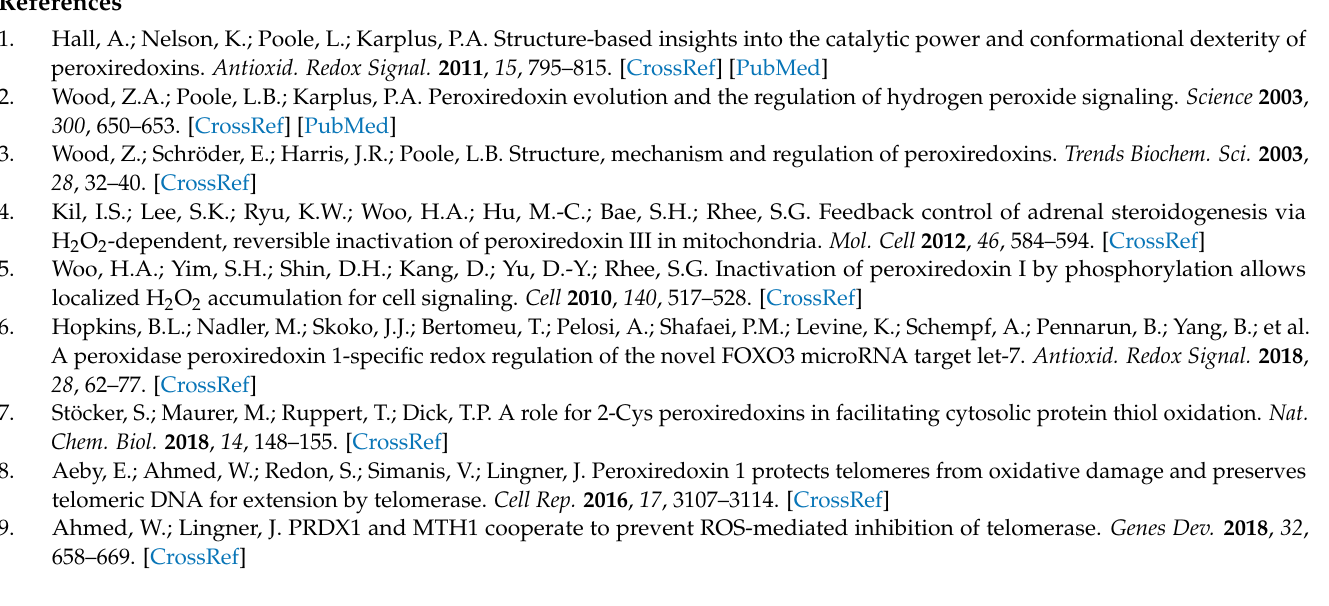
ESI-TOF MS, Table S1: Crystallographic data and refinement statistics, Table S2: k SOH formation rates as determined by HRP competition